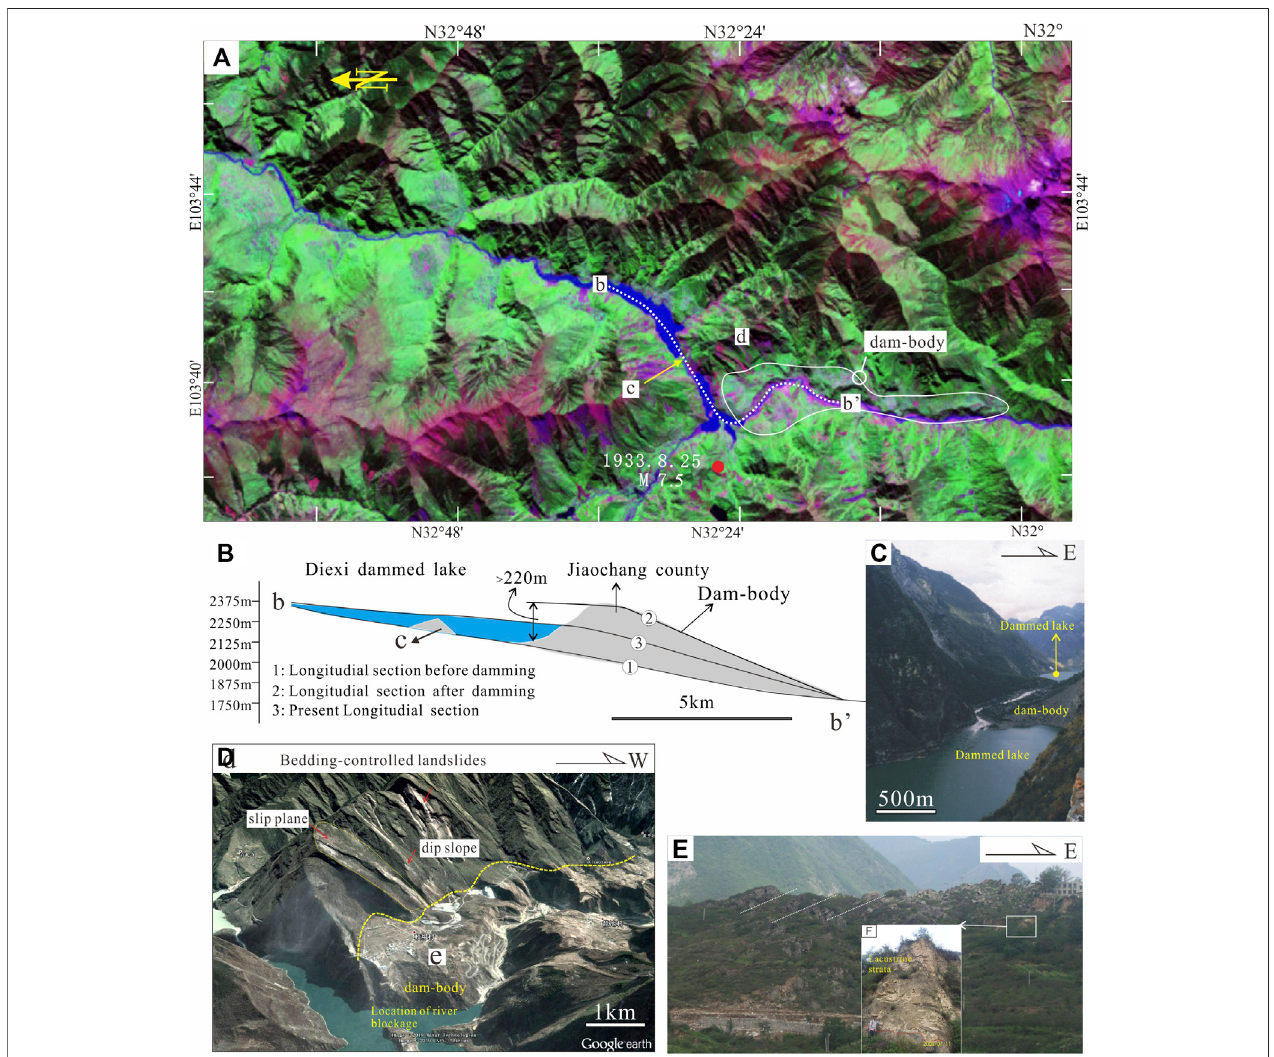
FIGURE4|(A) SatelliteimageandsectionsoftheDiexidammedlakealongtheMinjiangRiver(modi fi edfromLietal.,2010). (B) Theconceptuallongitudinalsection acrosstheDiexidammedlake(modi fi edfromLietal.,2014). (C) FieldphotosoftheDiexidammedlake. (D) Landslidesurfaceonthenorthsideofthedammedlake. (E,F) Examples of the huge gravel in the debris that consisting the